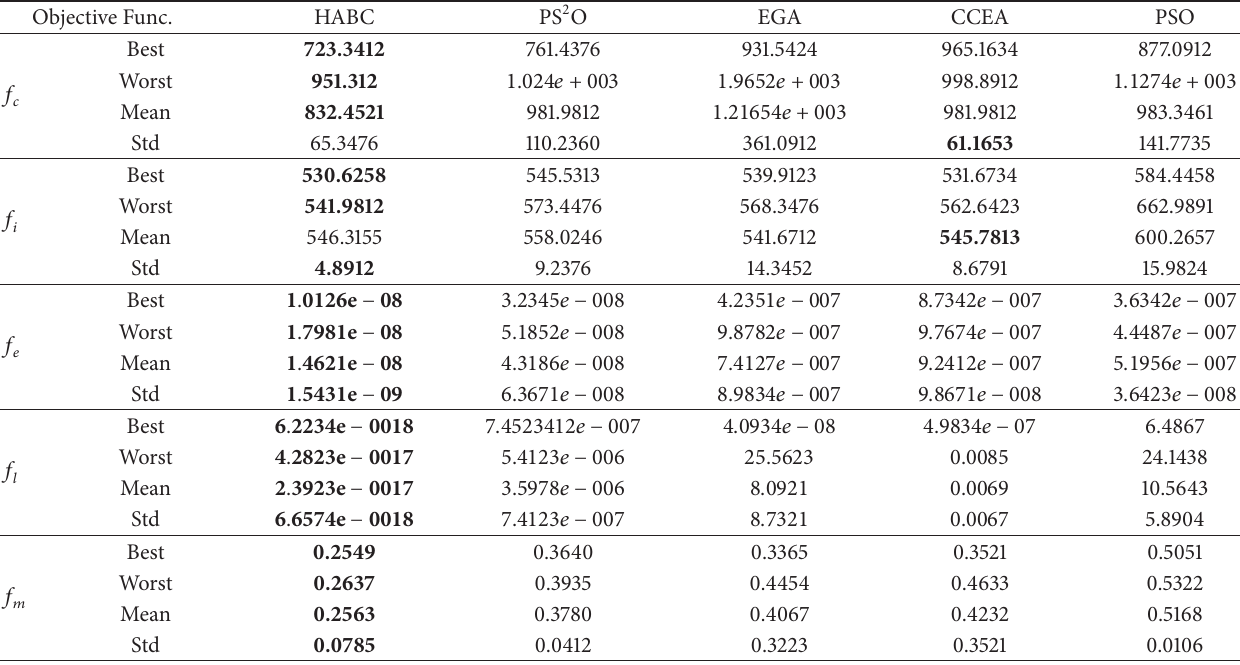
Table 8: Performance of all algorithms on RNP with